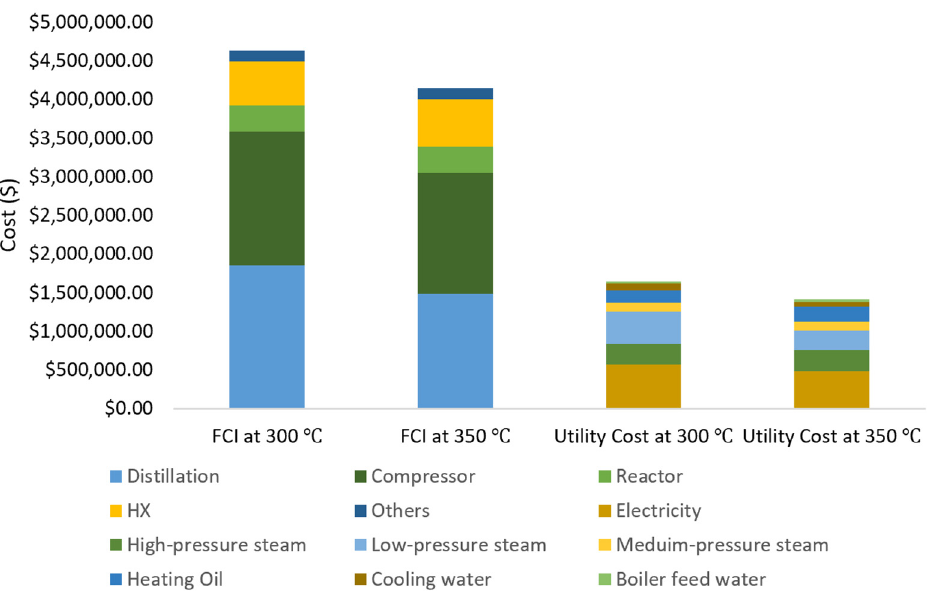
Figure 8. A comparison between the effect of the eactor temperature on the FCI and the utility cost.